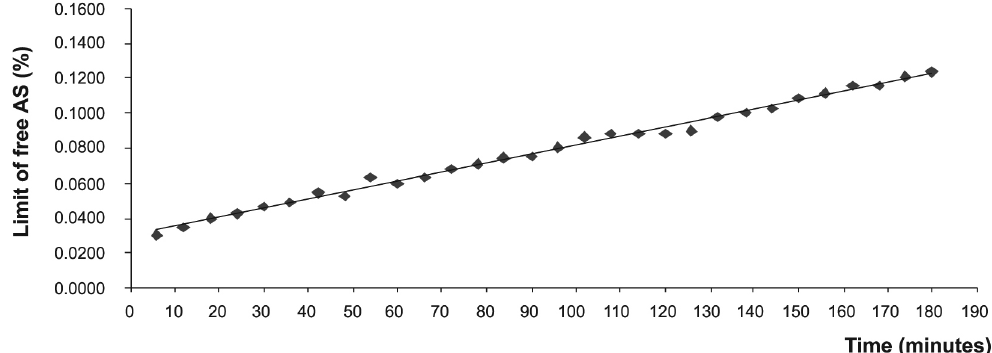
FIGURE 3 - Curve of the kinetic of salicylic acid formation from a standard solution of acetylsalicylic acid (0.302 mg/mL).